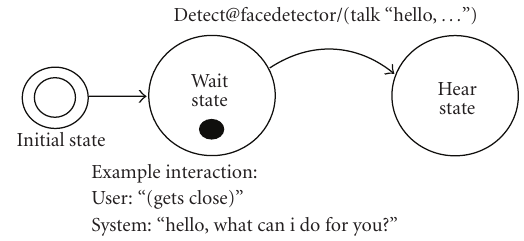
Figure 2: Example of state-transition model using multichannel